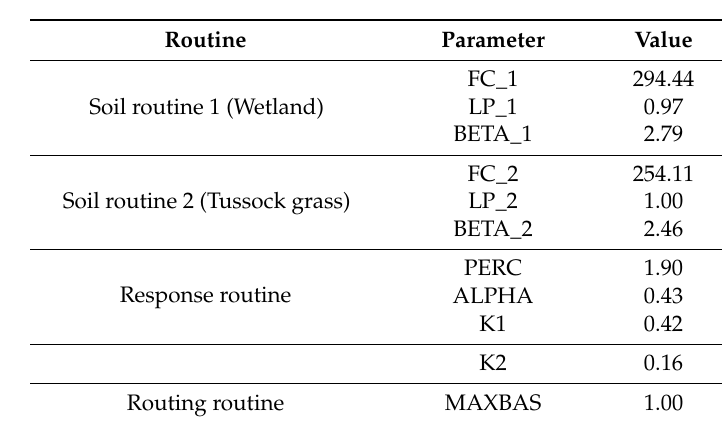
Table 6. Optimal parameters from the best runoff simulation according to